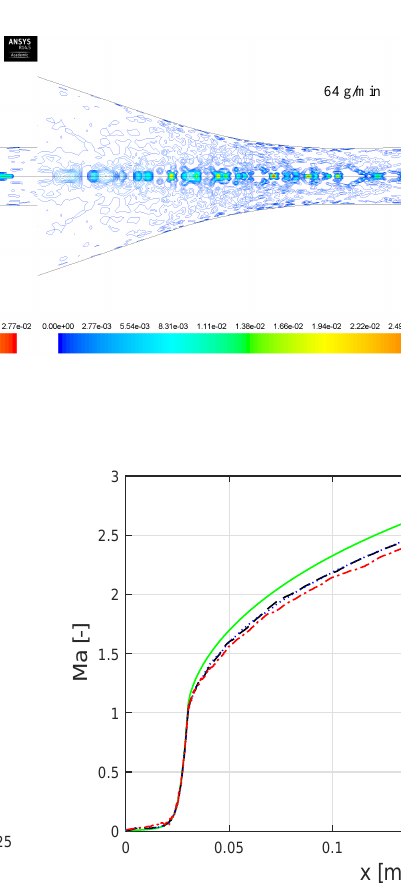
Figure 8. Comparison of nitrogen velocity profiles along axial po- sition (coupled).